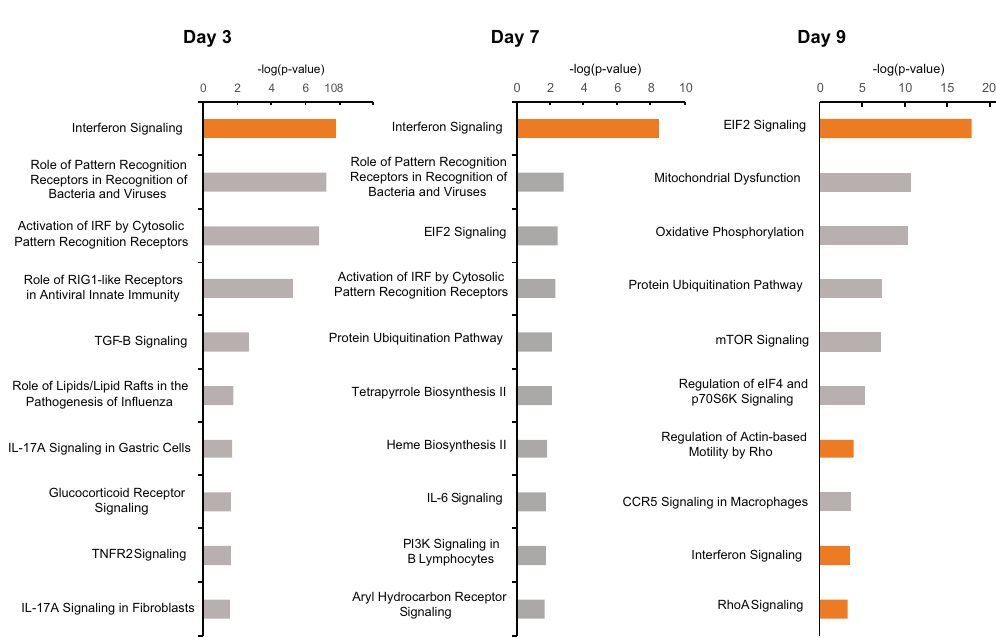
Figure 4. Top 10 canonical pathways associated with acute ZIKV infection by transcriptome profiling. Shown are the top 10 pathways at days 3, 7, and 9 post-inoculation, ranked by the negative log of the P-value of the enrichment score. The color scheme is based on Z-scores, with activation in orange and undetermined directionality in